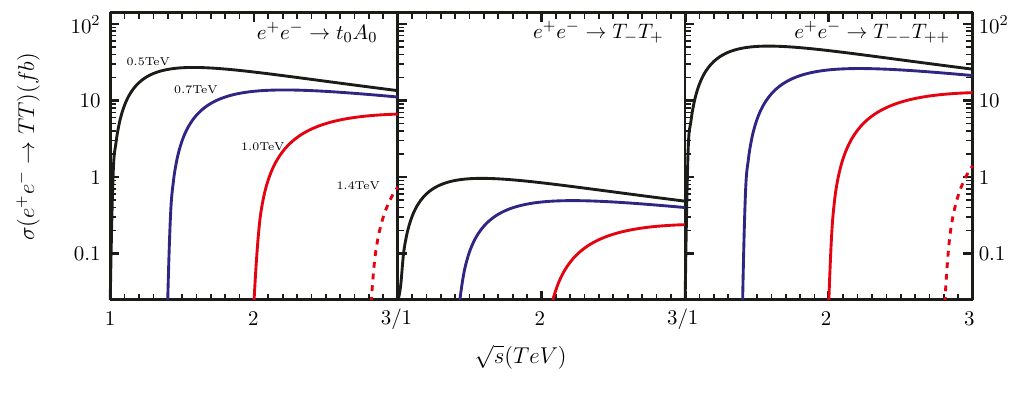
Figure 7 . The pair production cross sections ( in fb ) for four different masses, M T = 0 . 5 , 0 . 7 , 1 . 0 , 1 . 4 TeV, vs. √ s at the e + e −